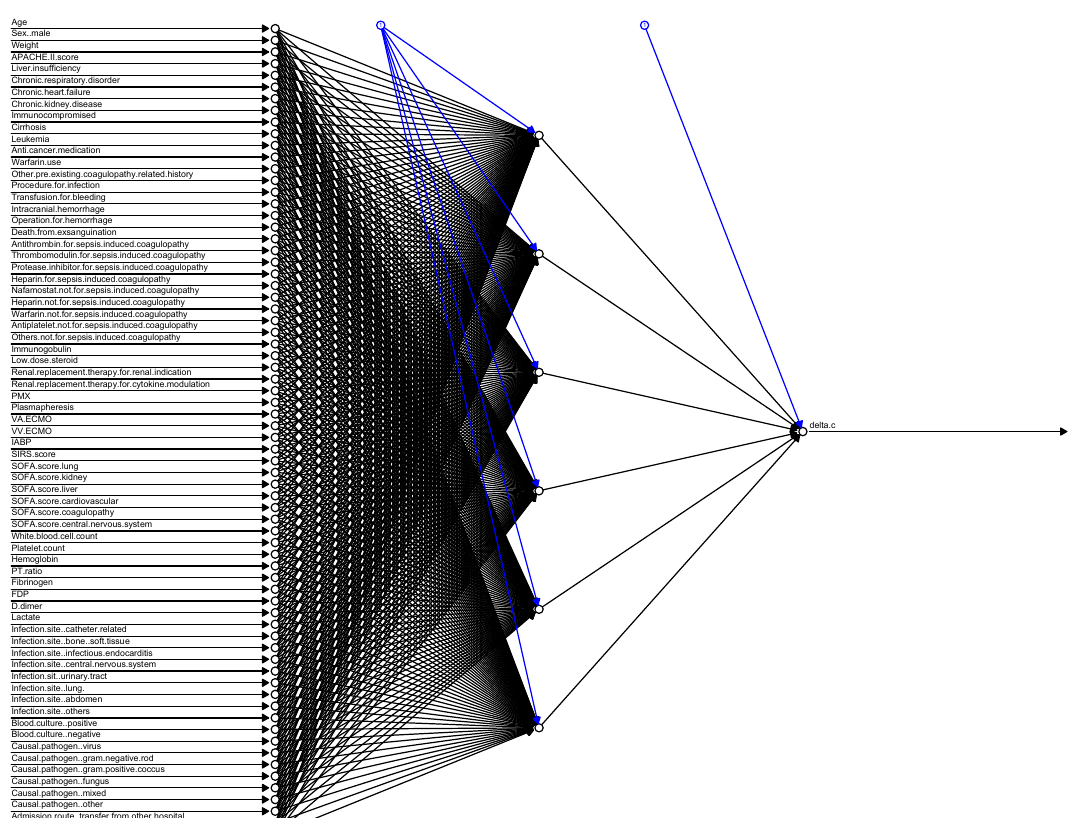
FDPFibrinogenPT.ratioHemoglobinPlatelet.countWhite.blood.cell.countSOFA.score.central.nervous.systemSOFA.score.coagulopathySOFA.score.cardiovascularSOFA.score.liverSOFA.score.kidneySOFA.score.lungSIRS.scoreIABPVV.ECMOVA.ECMOPlasmapheresisPMXRenal.replacement.therapy.for.cytokine.modulationRenal.replacement.therapy.for.renal.indicationLow.dose.steroidImmunogobulinOthers.not.for.sepsis.induced.coagulopathyAntiplatelet.not.for.sepsis.induced.coagulopathyWarfarin.not.for.sepsis.induced.coagulopathyHeparin.not.for.sepsis.induced.coagulopathyNafamostat.not.for.sepsis.induced.coagulopathyHeparin.for.sepsis.induced.coagulopathyProtease.inhibitor.for.sepsis.induced.coagulopathyThrombomodulin.for.sepsis.induced.coagulopathyAntithrombin.for.sepsis.induced.coagulopathyDeath.from.exsanguinationOperation.for.hemorrhageIntracranial.hemorrhageTransfusion.for.bleedingProcedure.for.infectionOther.pre.existing.coagulopathy.related.historyWarfarin.useAnti.cancer.medicationLeukemiaCirrhosisImmunocompromisedChronic.kidney.diseaseChronic.heart.failureChronic.respiratory.disorderLiver.insufficiencyAPACHE.II.scoreWeightSex..maleAge Figure 3. Construction of the neural network model for the prediction of sepsis-induced coagulopathy progression. APACHE, Acute Physiology and Chronic Health Evaluation; PMX, polymyxin B